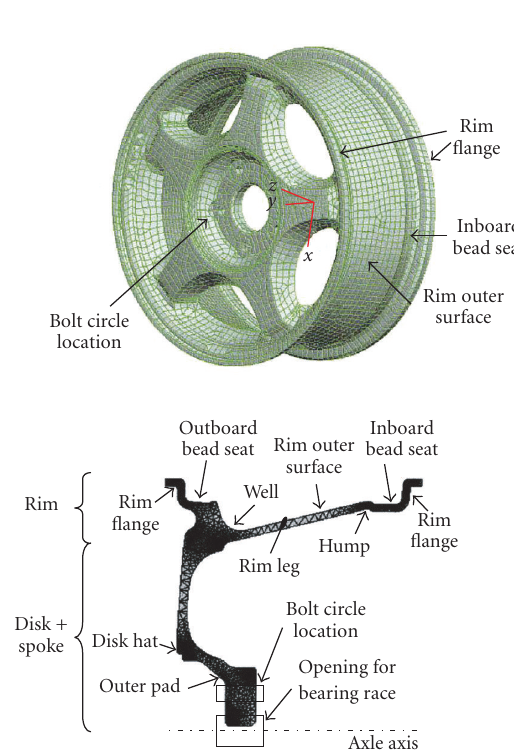
Figure 2: The full finite element model of the wheel and terminol- ogy related to a wheel.